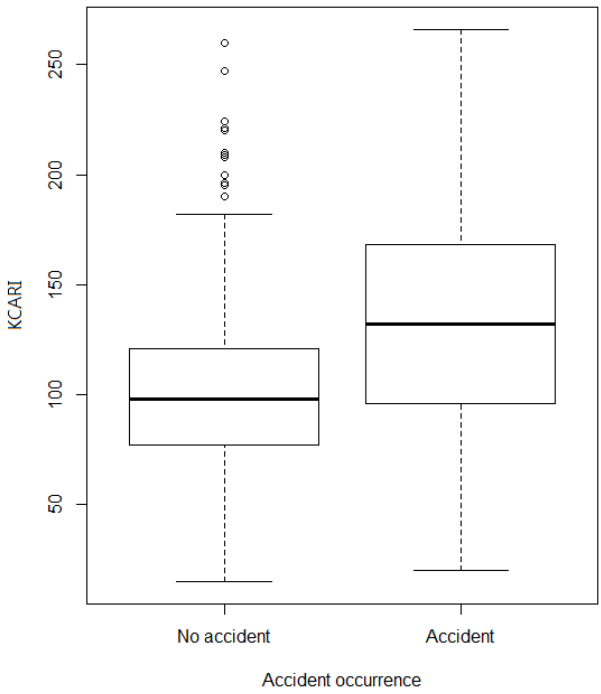
Figure 1. The average KCARI by accident occurrence.